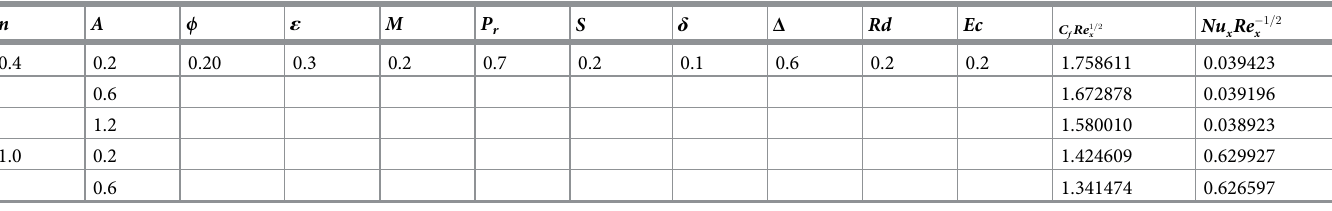
and Nu for diverse flowing Re 1 = 2 Re (cid:0) 1 = 2 f x x x